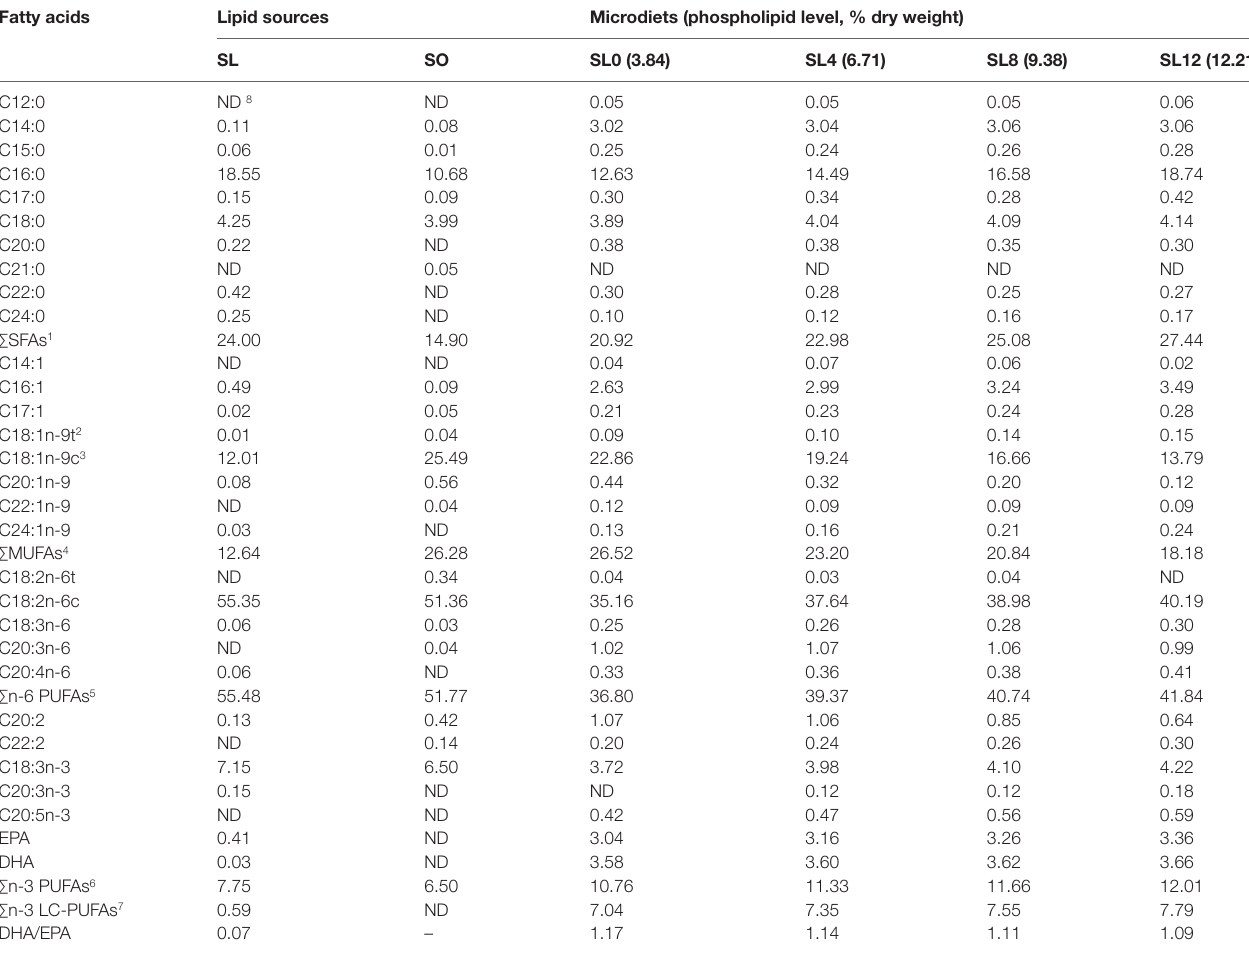
TABLE 2 | Lipid sources, and MD fatty acid composition (%, identified fatty acids). Fatty